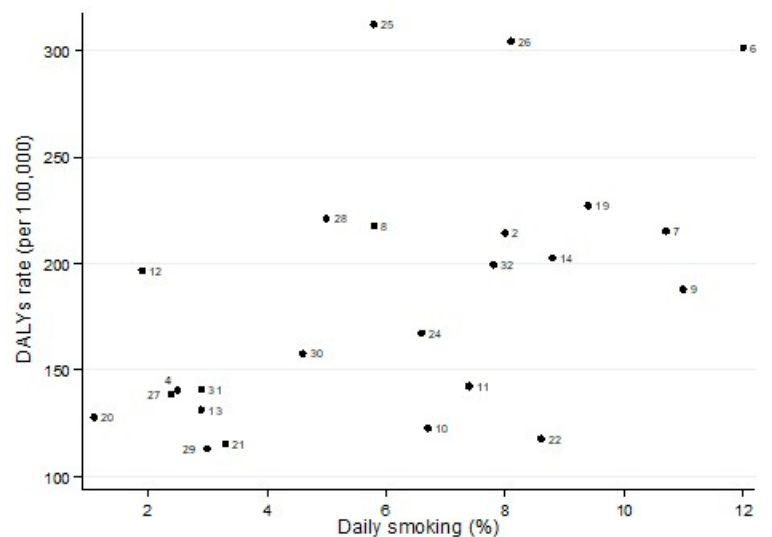
Figure 2. Proportion (%) of adult daily smokers and Disability-Adjusted Life-Years (DALYs) rate (per 100,000) due to tracheal, bronchus, and lung cancer in both genders, Mexico 2019. Note: (a) Spearman’s rank correlation coefficient (rho) was 0.56 ( 𝑝 = 0.001); (b) 2, Baja California; 4, Campeche; 6, Chihuahua; 7, Coahuila; 8, Colima; 9, Durango; 10, Estado de M é xico; 11, Guanajuato; 12, Guerrero;